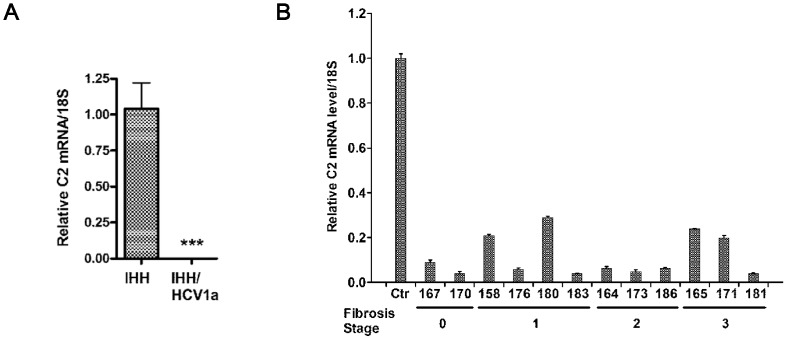
HCV infection inhibits mRNA expression of C2 complement component.(A) Real-time PCR analysis for C2 mRNA expression from HCV infected IHH and mock infected control cells. Results were normalized to endogenous 18S RNA. Asterisks denote: *p<0.05; **p<0.01; ***p<0.001 when compared to controls. (B) Real-time PCR analysis displaying HCV genotype 1a infection represses C2 expression in chronically infected liver biopsy specimens from patients (n = 12). Liver biopsy samples are each marked by 3-digit numbers at the bottom. Results are compared with non-HCV infected 3 control liver tissues arbitrarily set at 1. The error bars in individual samples are shown as variations form triplicate assays. All samples used in this study were significantly inhibited (p<0.01) as compared to negative controls.